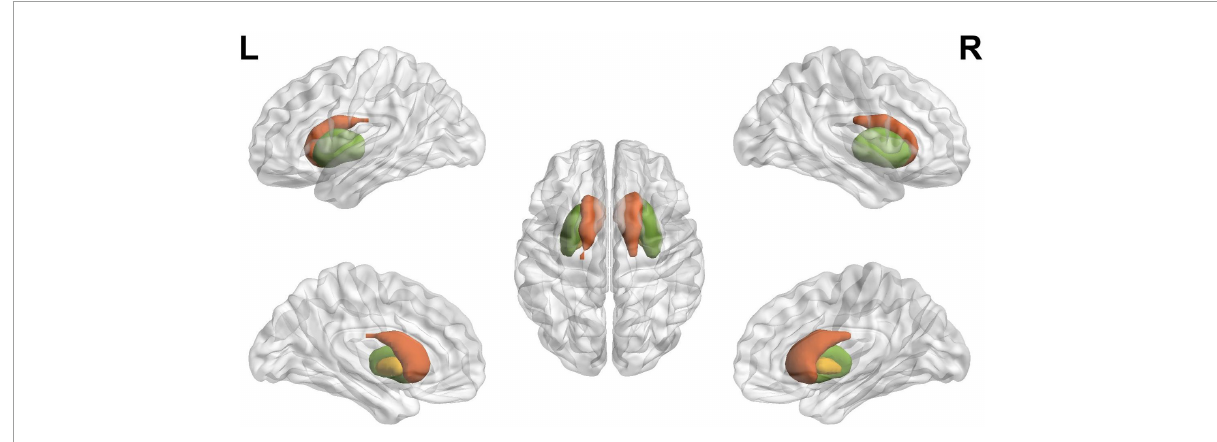
FIGURE1 The schematic diagram of striatum, where red, green, and yellow indicate caudate, putamen, and pallidum, respectively, defined using the BrainNet viewer.